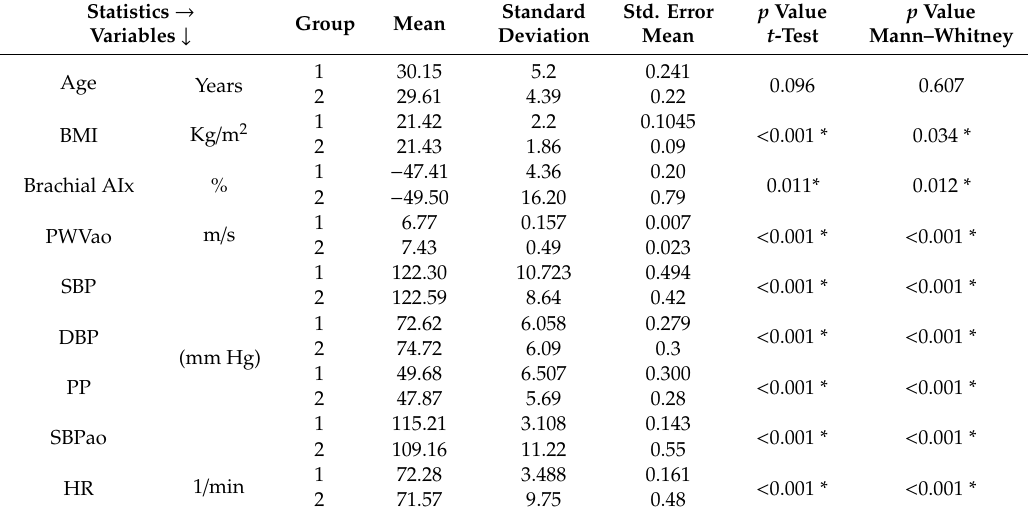
Table 3. The primary descriptive statistics, the p values obtained using both Student t unpaired test and the Mann–Whitney test, applied on the numerical variables for both groups (N1 = 471, N2 = 416).